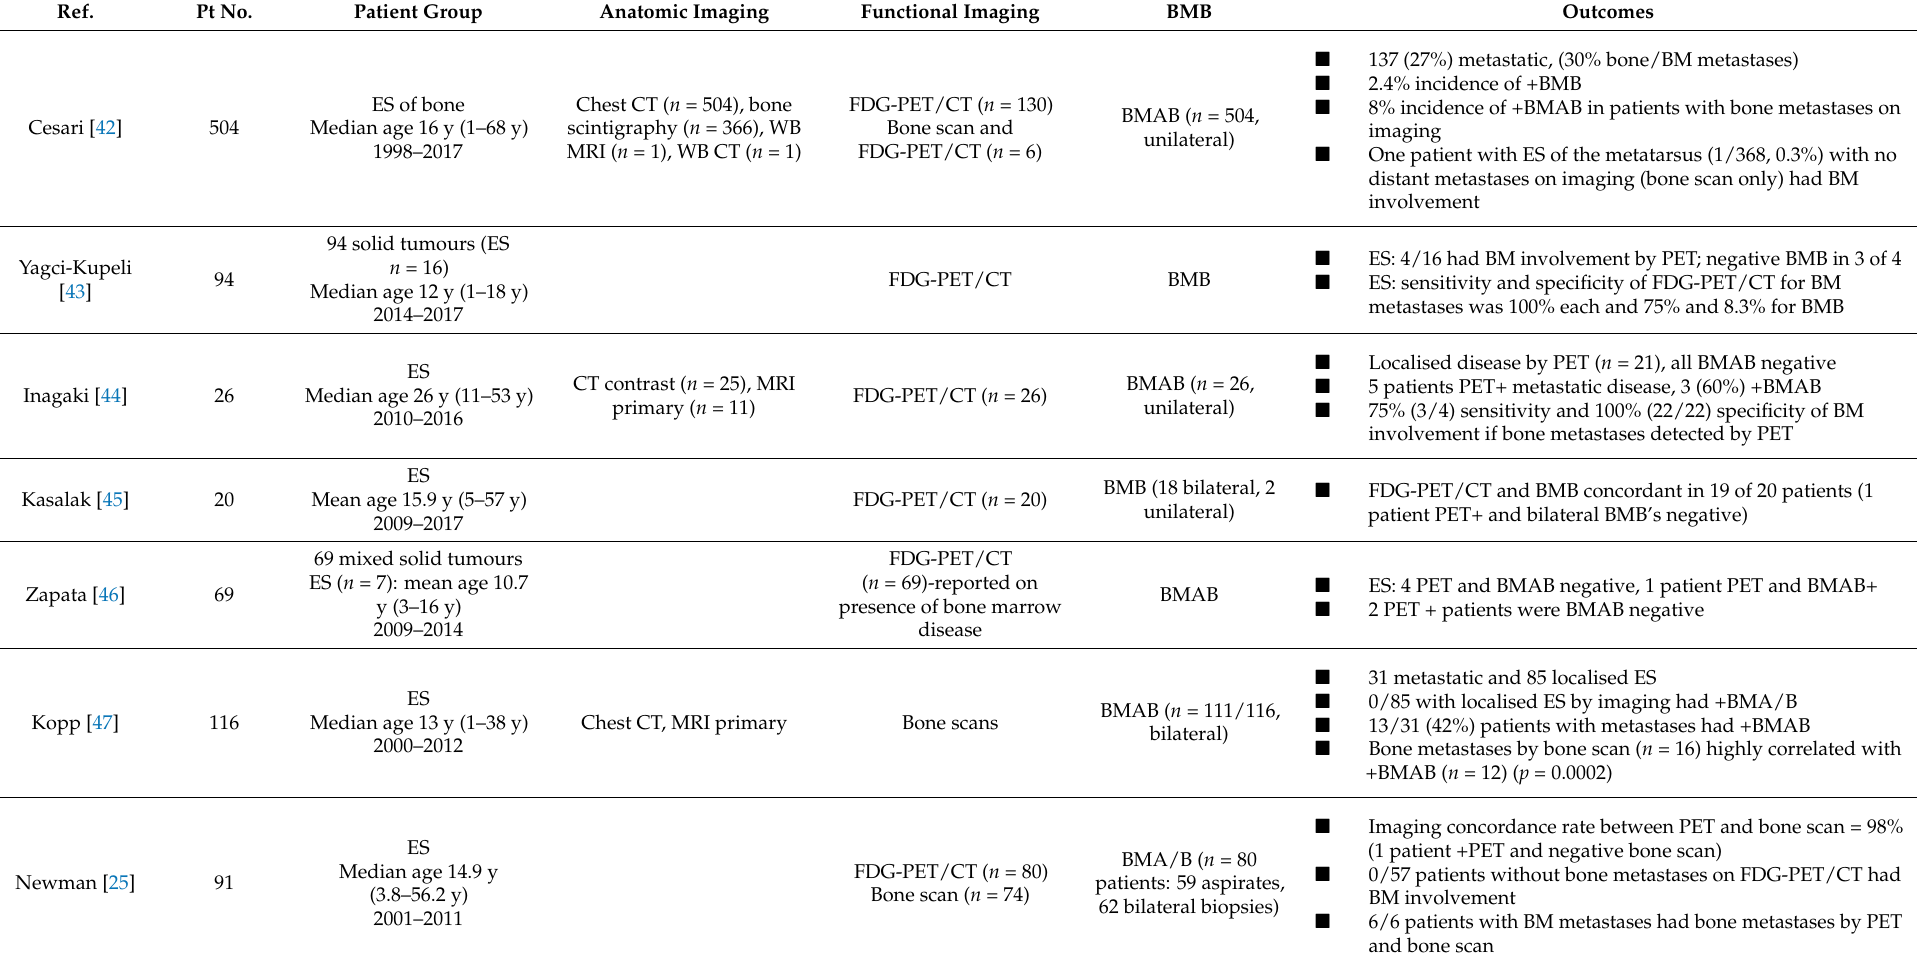
Table 1. Retrospective studies comparing imaging modalities to bone marrow biopsy (BMB) in previously untreated ES.